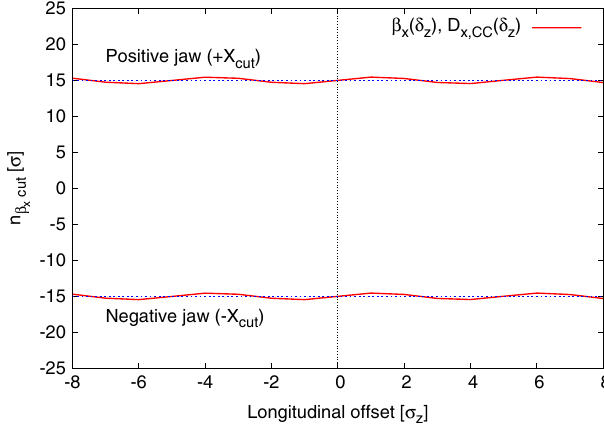
FIG. 8. (Color) Phase space cut with crab dispersion from the primary collimator TCP.6L3.B1.